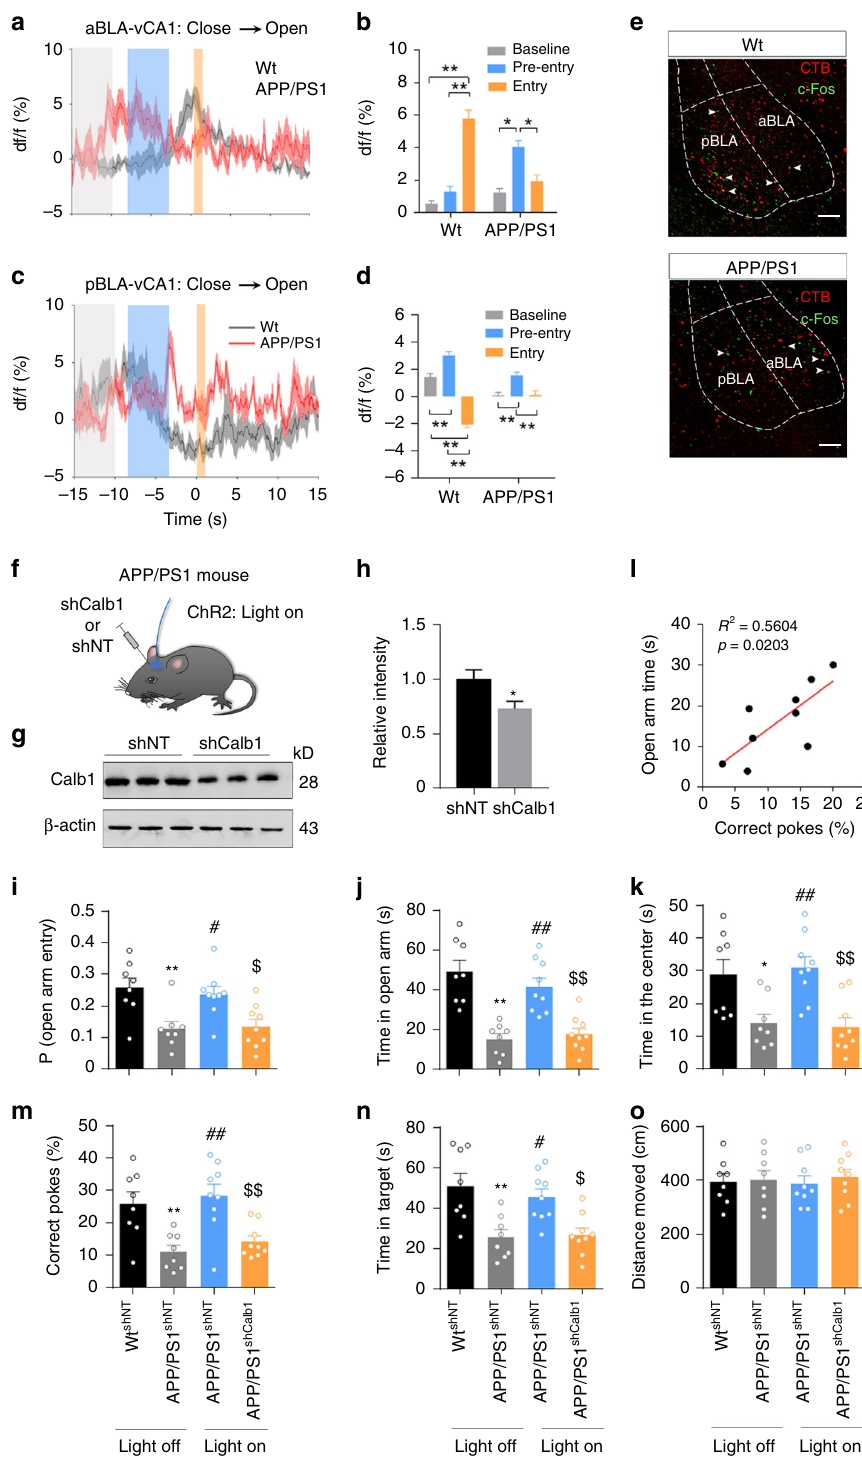
Fig. 14b, c). Simultaneously, the anxiolytic effect induced by pBLA – vCA photostimulation was abolished, as evidenced by the reduced open-arm entries and open-arm exploration time in EPM (Supplementary Fig. 16d, e) and the reduced centre exploration time in OFT (Supplementary Fig. 16f). No difference in motor function was detected among the groups (Supplemen- tary Fig. 16g). Furthermore, downregulating Calb1 by the injection of AAV-shCalb1 in the vCA1 (Fig. 6f – h) abolished 10 NATURE COMMUNICATIONS| (2020) 11:183